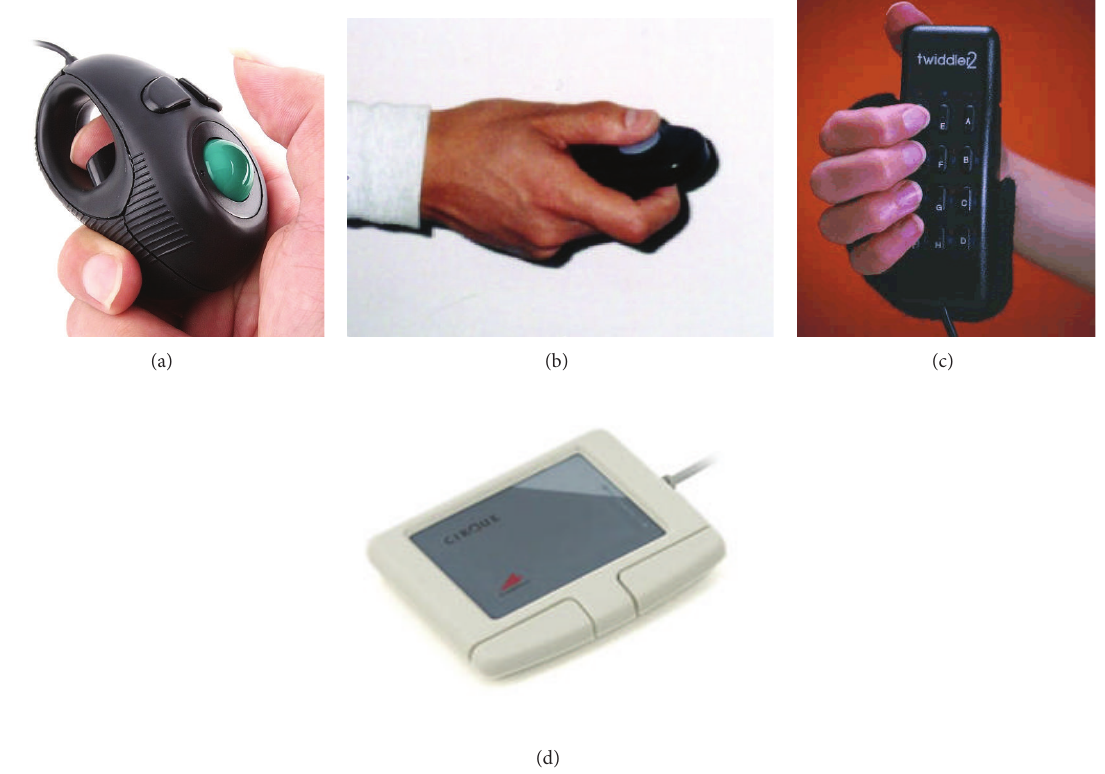
Figure 1: Adaptations of traditional pointing devices. (a) The 4D Off-Table Hand Track mouse , (b) the RemotePoint , (c) the Twiddler2 , and (d) the EasyCat Touchpad . (a)–(d) from [14, 25–27],